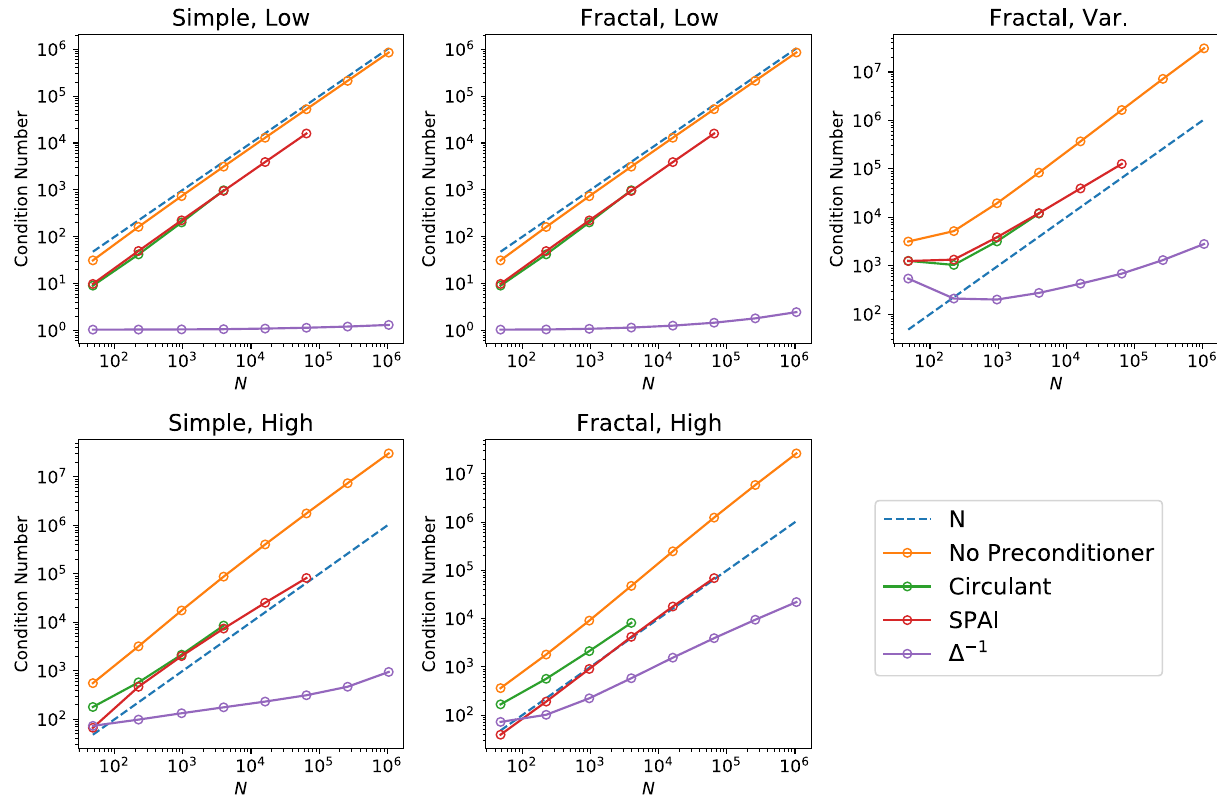
1 gives the best scaling in all